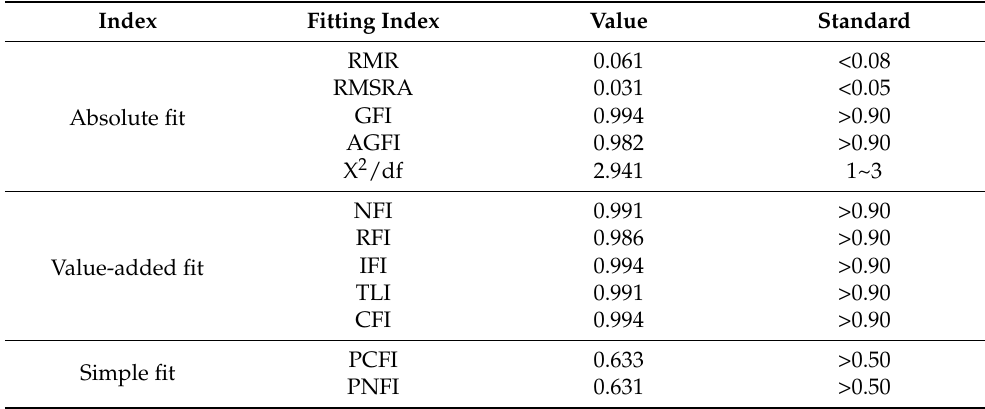
Table 3. Structural equation fit